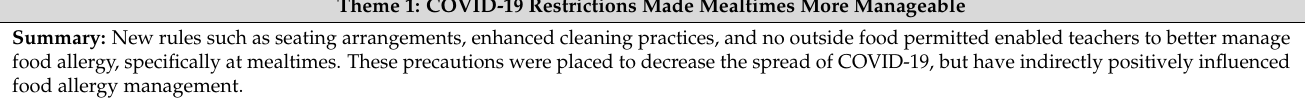
Table 2. Qualitative themes, summary statement, codes, and supporting quotations of COVID-19- related restrictions on food allergy